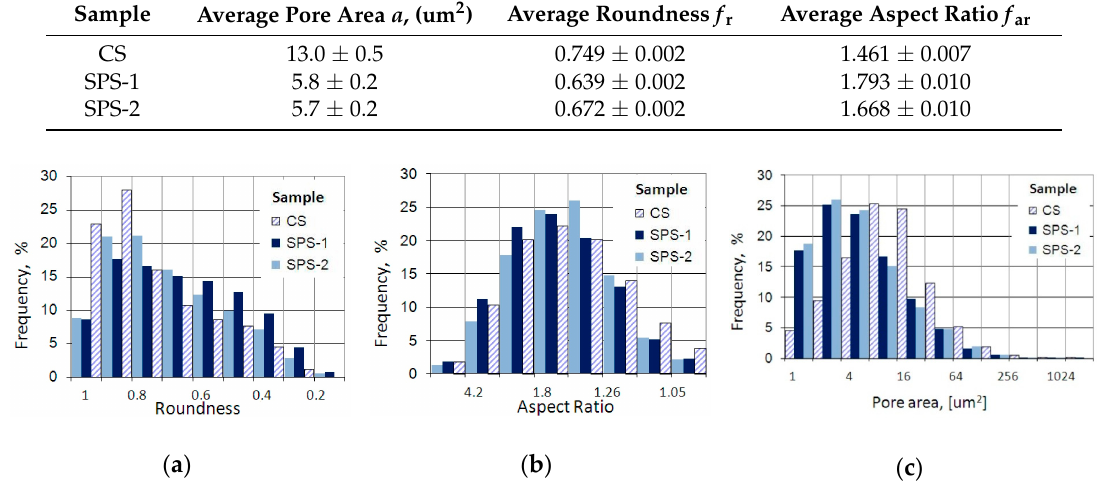
Figure 6. Comparison of porosity structure in products sintered by various methods: ( a ) the distribution of roundness ( f r ); ( b ) the distribution of aspect ratio ( f ar ); and ( c ) the distribution of the size of pores ( a ).